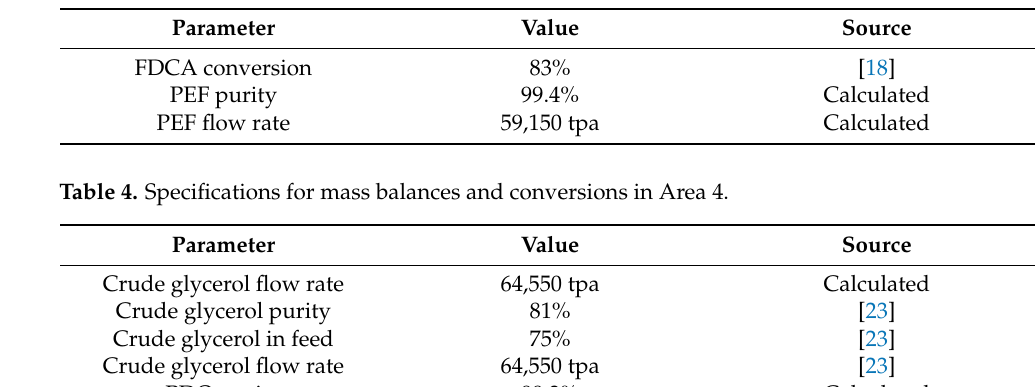
Table 3. Specifications for mass balances and conversions in Area 3.